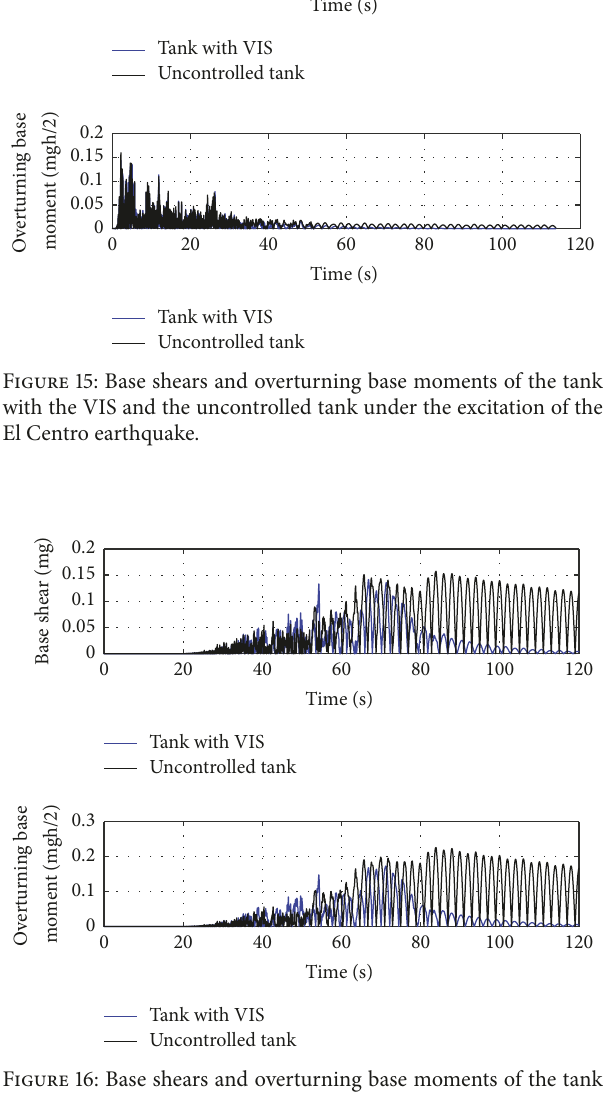
Figure 16: Base shears and overturning base moments of the tank with the VIS and the uncontrolled tank under excitation of the Chi- Chi